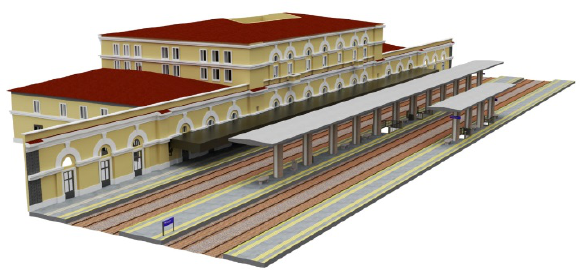
Figure 3. Three-dimensional model of Fontivegge